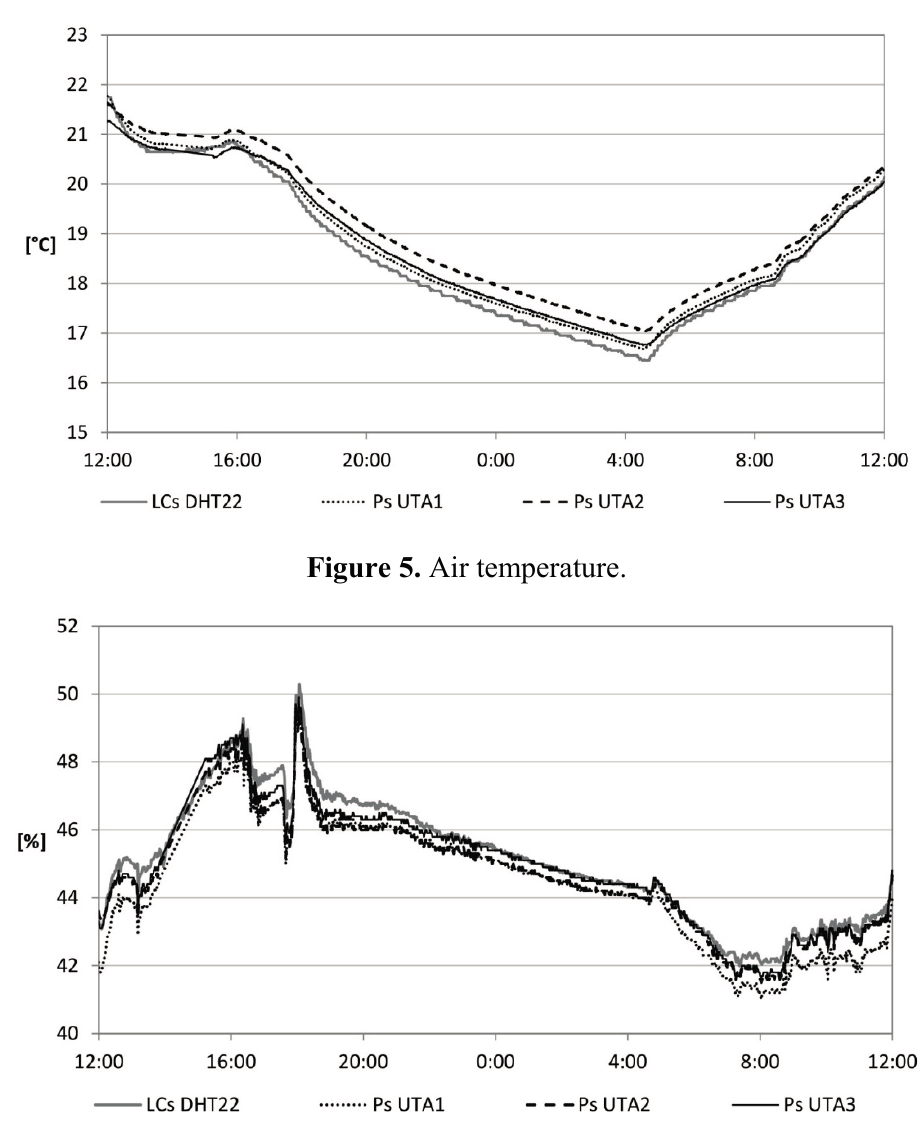
Figure 6. Relative humidity of the